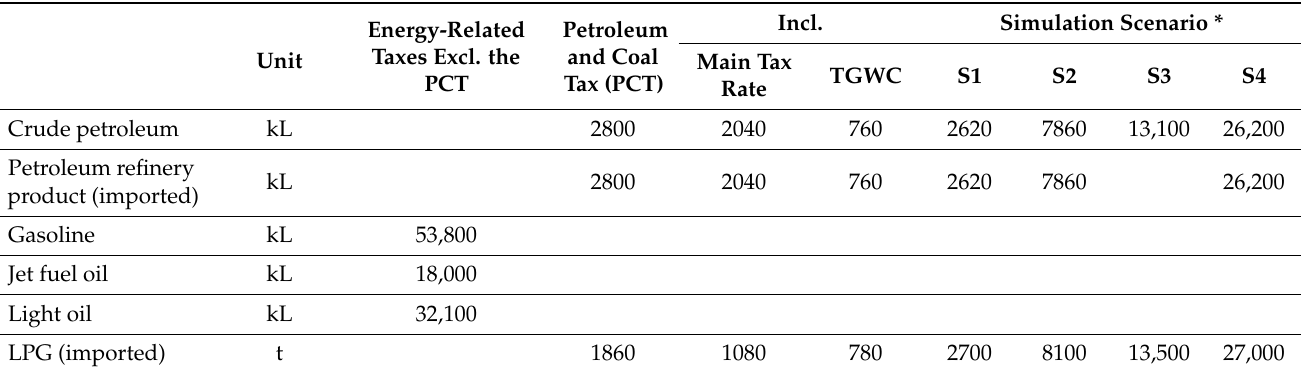
Table 1. Energy-related taxes in Japan